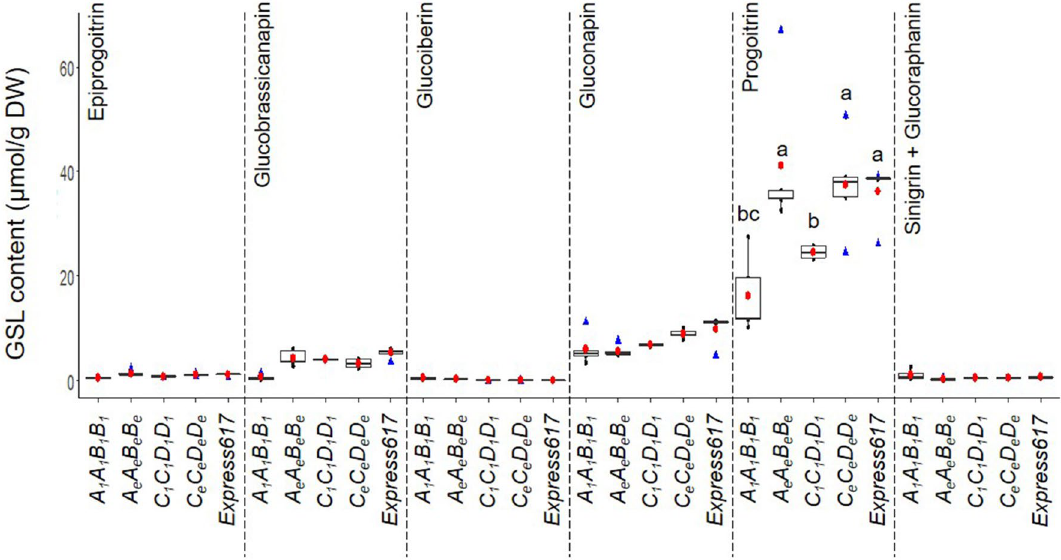
Figure 5. Analysis of aliphatic glucosinolates in mature seeds of BnMYB28 and BnCYP79F1 mutants. Individual aliphatic GSLs in homozygous F 2 BnMYB28 (genotype A 1 A 1 B 1 B 1 , seed code 200527) and BnCYP79F1 (genotype C 1 C 1 D 1 D 1 , seed code 200529) double mutants originating from M 3 xM 3 crosses. F 2 plants homozygous for the wildtype alleles ( A e A e B e B e and C e C e D e D e ) and non-mutated Express617 were used as controls.